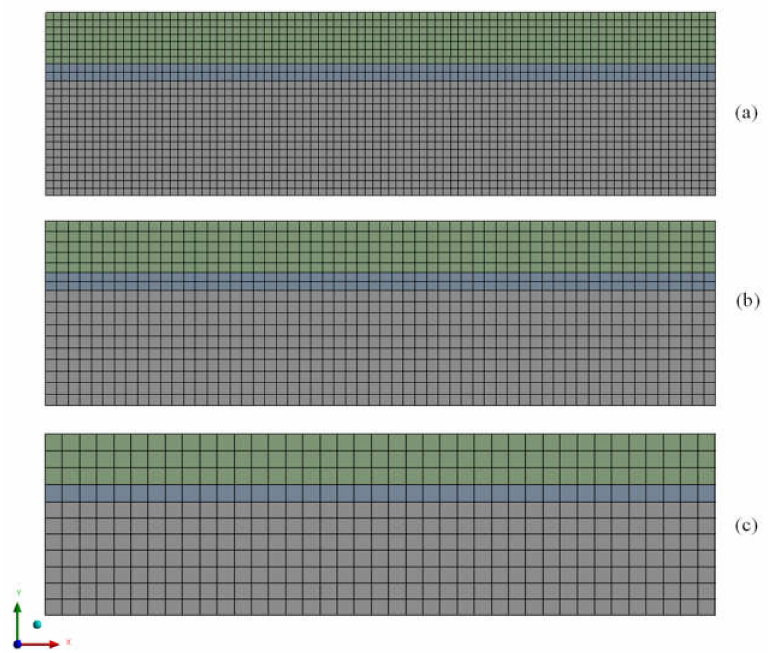
Figure 3. Two-dimensional mesh of the tubular membrane cross-section: ( a ) Mesh M 1 , ( b ) Mesh M 2 , and ( c ) Mesh M 3